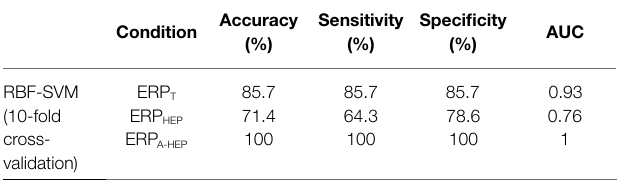
TABLE 3 | Results of the classification by RBF-SVM (10-fold cross-validation) with ERP T , ERP HEP , and ERP A-HEP epochs ( n = 24). Accuracy Condition (%)